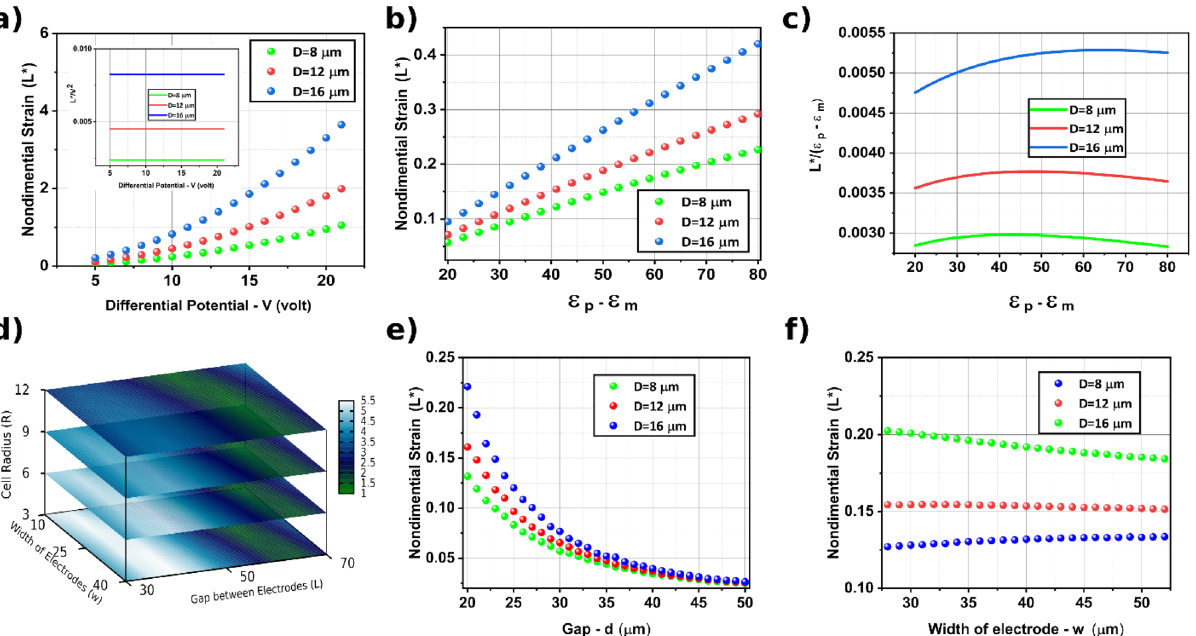
Figure 6. Study of the effect of the different parameters on cell elongation. ( a ) Variation of non-dimensional strain vs differential potential. The inset gives the fact that elongation is directly dependent on power two of the applied voltage. ( b ) Variation of non-dimensional strain vs the difference between medium and cell permittivity. ( c ) Normalized non-dimensional strain with the difference of medium and cell permittivity vs difference of medium and cell permittivity, which shows a nonlinear relationship. ( d ) Error expected in approximation used to simplify elongation’s dependency on the permittivity of particle and medium. The error for different sizes of cells and electrodes is less than 5.5. ( e ) Variation of non-dimensional strain vs gap ( d ) Variation of non- dimensional strain vs width of